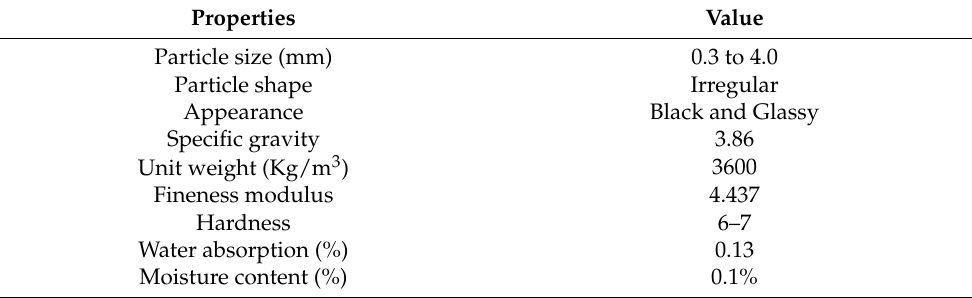
Table 4. Physical properties of copper slag.